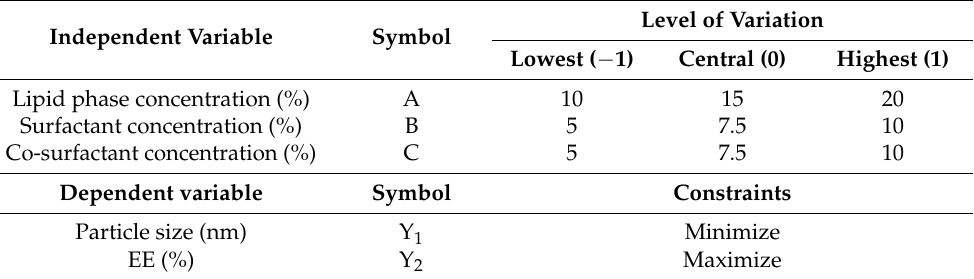
Table 1. Data from BBD displaying the independent variables with their level of variation and the studied dependent variables.